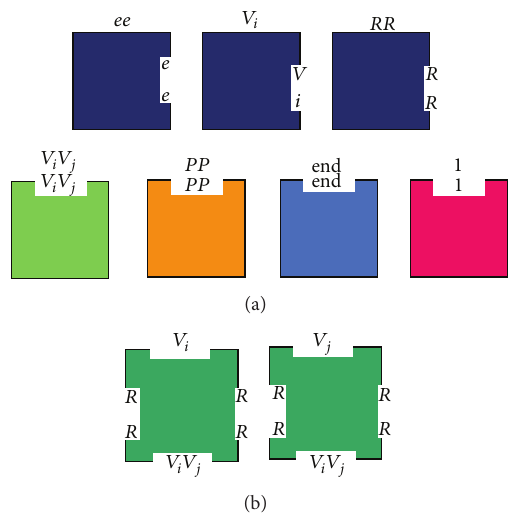
Figure 1: (a) Tiles in Γ 𝑠𝑒𝑒𝑑 with the name written on the top; (b) the meaning of the tiles in 𝑇 V to encode edges 𝑉 𝑖 𝑉 𝑗 and vertex 𝑉 𝑖 or 𝑉 𝑗